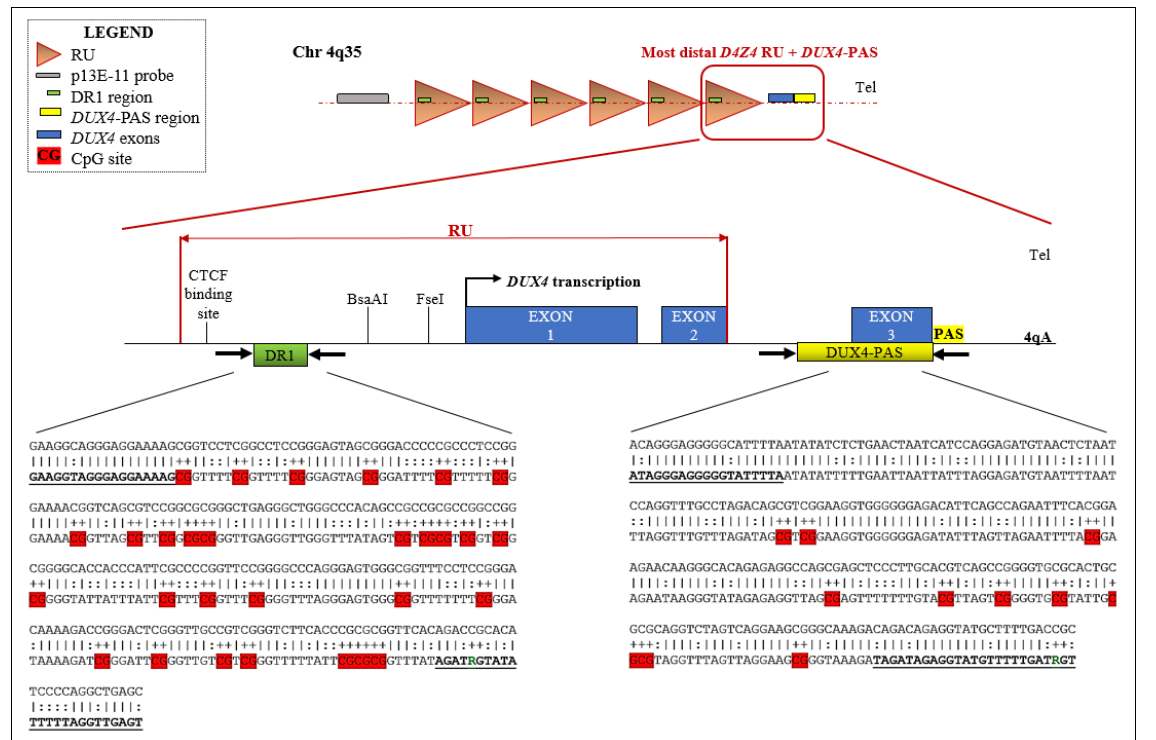
Figure 1. Schematic representation of the analyzed D4Z4 regions together with their sequence within the D4Z4 locus. The figure illustrates the locations of DR1 and DUX4 -PAS target regions into the D4Z4 . Moreover, the most distal D4Z4 unit, encompassing the whole DUX4 ORF is shown. For each target region, the corresponding sequence is reported. The upper line shows the non-converted genomic sequence, whereas the lower line displays the bisulfite converted sequence (as predicted by MethPrimer.com, accessed on 3 September 2022). Herein, the harbored specific CpG sites (29 CpGs for DR1 and 10 CpG for DUX4 -PAS, respectively) are highlighted in red. The sequence of the employed primers is shown in bold and underlined. In particular, the modified nucleotides (R) in the primer sequences are shown. PAS: Polyadenylation Signal; Tel.: